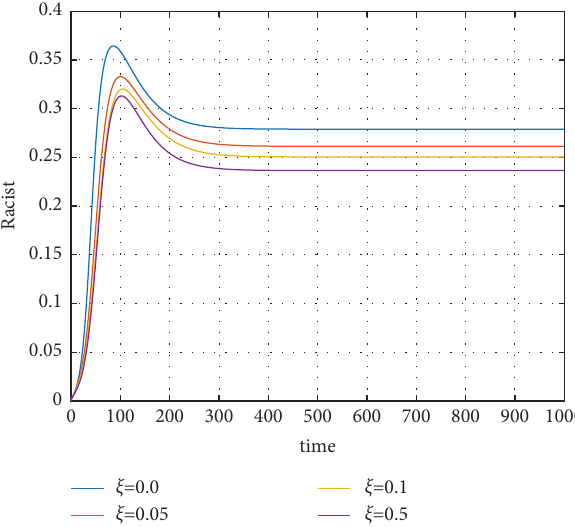
Figure 10: Impact of ξ on R ( t ) , if θ � 1.